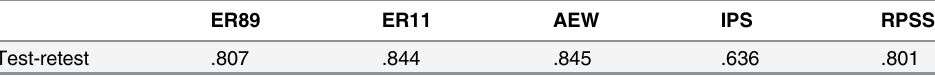
Table 2. Test-retest Pearson-correlations of the different versions and factors of the ego-resiliency scale.